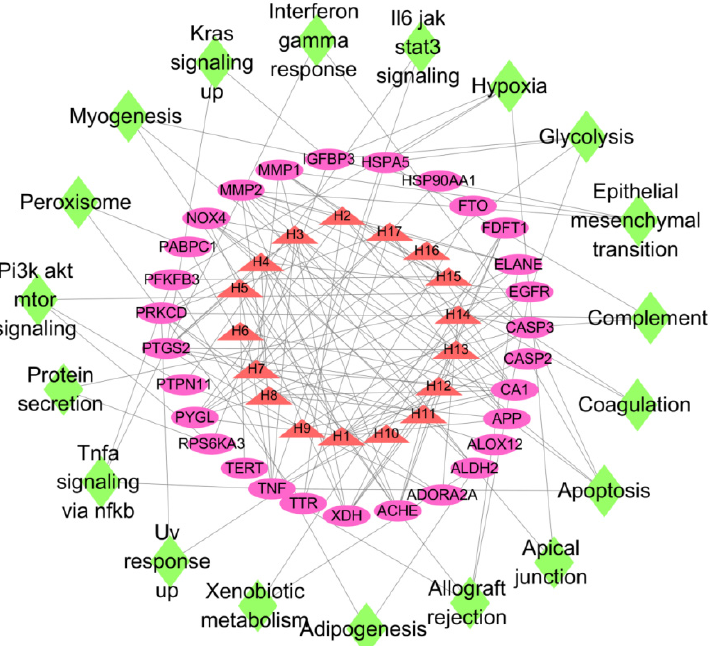
Figure 4. Components–targets–pathways network of LJF against NAFLD. Nodes with different colors represent active ingredients, targets, and pathways. Red triangle nodes represent active ingredients in LJT, purple oval nodes represent targets, and green diamond nodes represent pathways.